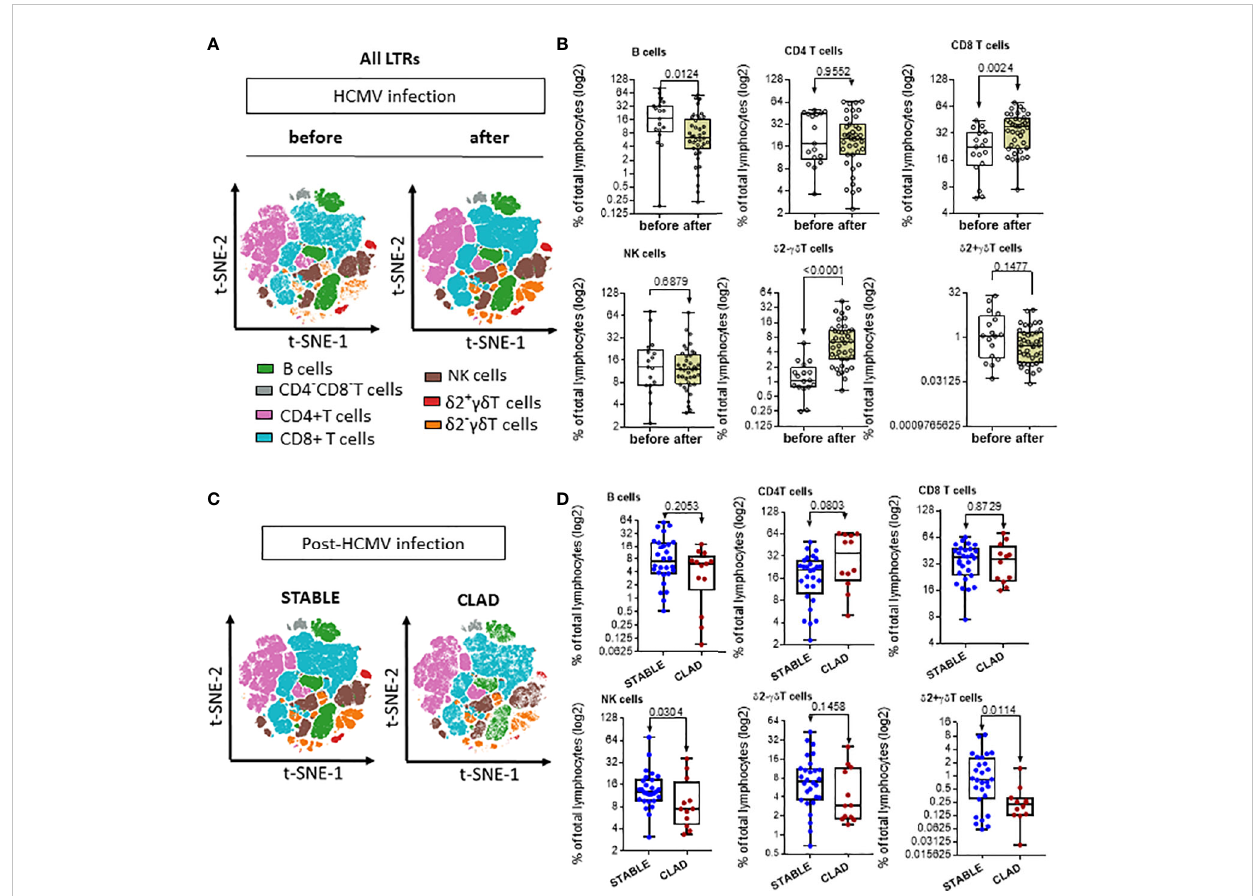
FIGURE 5 Signature of HCMV infection and signature of CLAD on the distribution of immune subsets in LTRs. (A) Visualization (opt-SNE) of the relative abundance of the seven main lymphocyte populations on samples from LTRs (STABLE and CLAD samples embedded) harvested before ( n = 17) and after ( n = 40) HCMV infection (left panel). Lymphocyte populations including B, NK, CD4 − CD8 − T, CD4 + T, CD8 + ab T, d 2 − gd T, and d 2 + gd T cells were identi fi ed using manual assignation based on phenotype markers (Figure S5). (B) Frequencies (% total) of the seven main lymphocyte populations identi fi ed (right panel). (C) Visualization (opt-SNE) of the relative abundance of the seven main lymphocyte populations in samples harvested after HCMV infection from either the STABLE ( n = 28 samples from 13 LTRs) or CLAD ( n = 12 samples from 5 LTRs) LTRs (left panel). (D) Frequencies (% total) of the seven main lymphocyte populations identi fi ed in CLAD versus STABLE LTRs (right panel). (A, B) Results are shown in whisker plots with median and interquartile values, and each point corresponds to an individual LTR. The groups were compared using the Mann – Whitney U test; p -values are